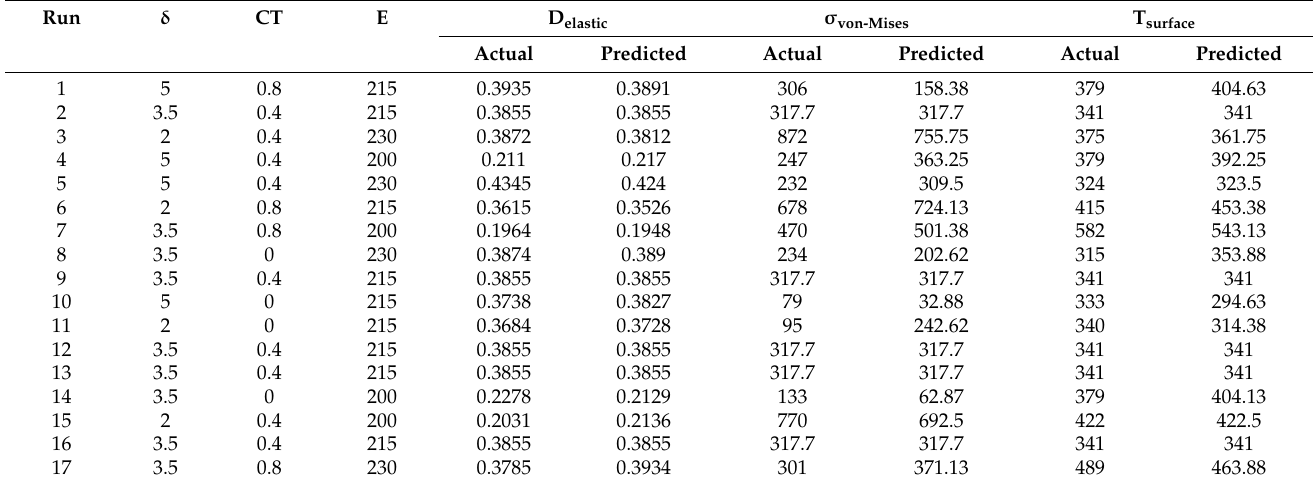
Table 5. Details of actual vs. predicted responses of output parameters (elastic).